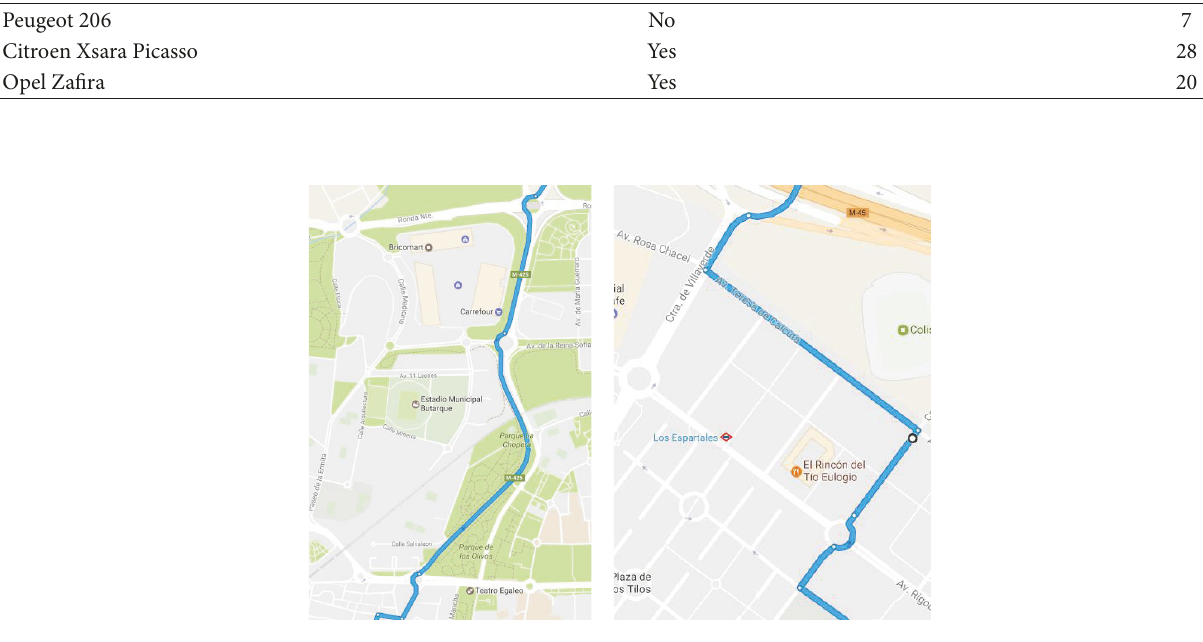
Figure 2: Driving path travelled in one direction.